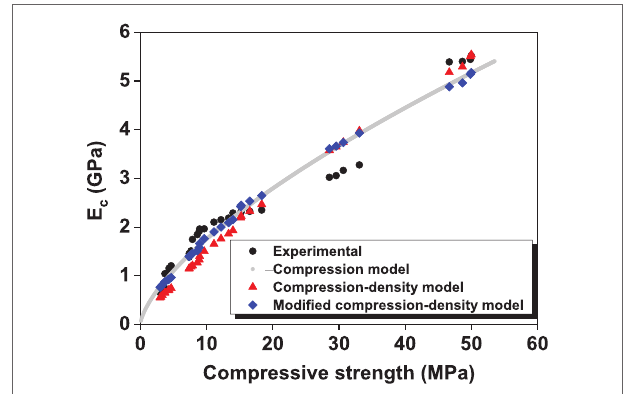
FigUre 10 | The relationship between the modulus of the gFcs and compressive strength